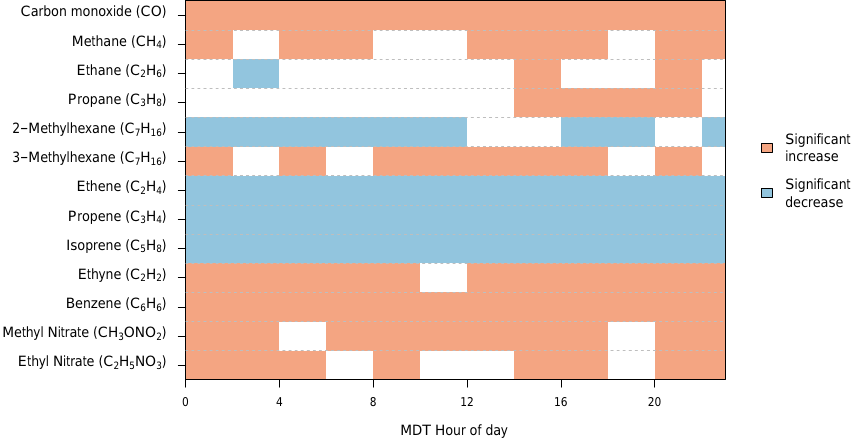
Figure 3. Significant changes (two-sided Student’s t test, 90% confidence interval) in hourly averaged mixing ratios of a subset of species measured at BAO between smoke-free periods and the 16–30 August smoke period. Significant increases during smoke-impacted periods compared to smoke-free periods are shown in red; significant decreases are in